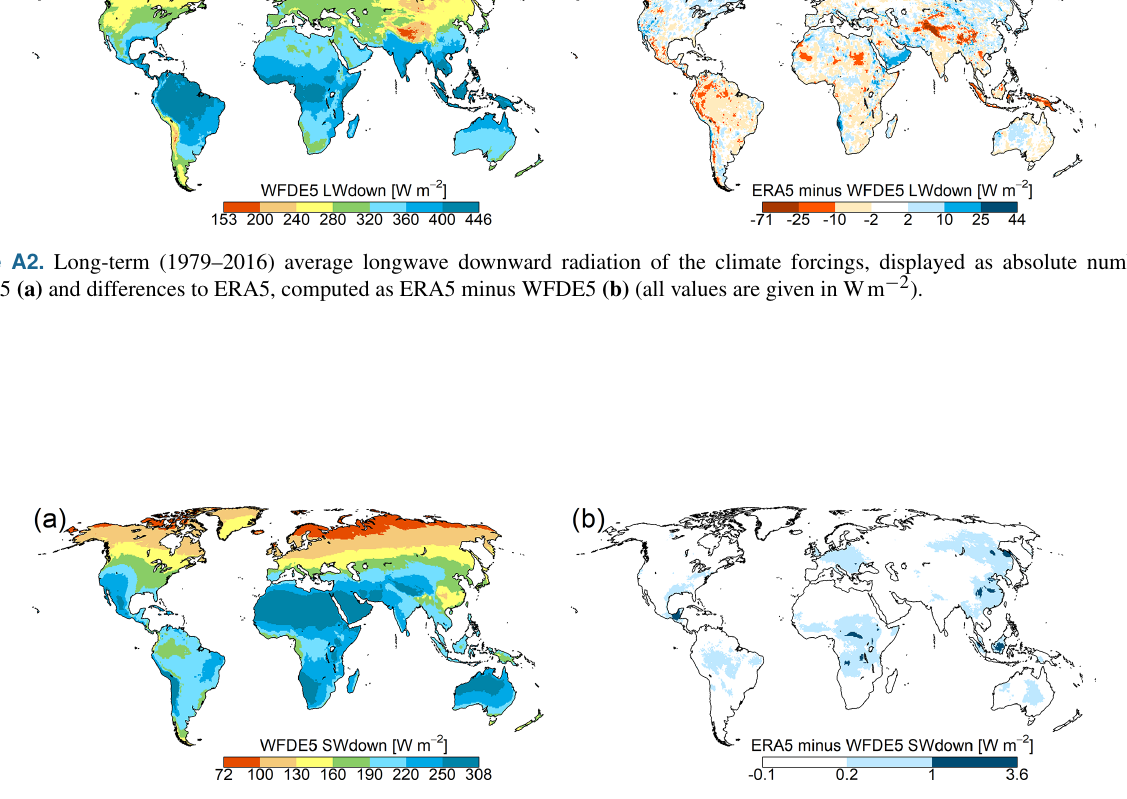
Figure A3. Long-term (1979–2016) average shortwave downward radiation of the climate forcings, displayed as absolute number for WFDE5 (a) and differences to ERA5, computed as ERA5 minus WFDE5 (b) (all values are given in Wm − 2